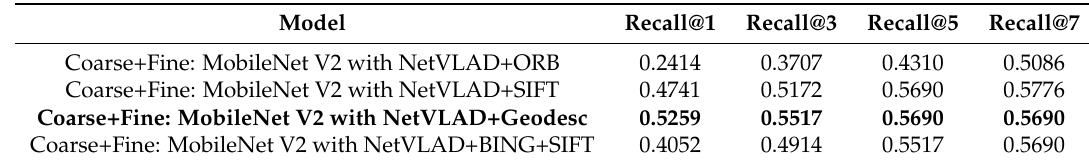
Figure 10. Pipeline of deciding top-1 candidate after implantation of BING salient region detection into a coarse-to-fine localizer. Table 8. Localization results of coarse-to-fine system when simplifying models on the Chengyuan dataset across summer and winter—subset 2 as query, subset 1 as database.